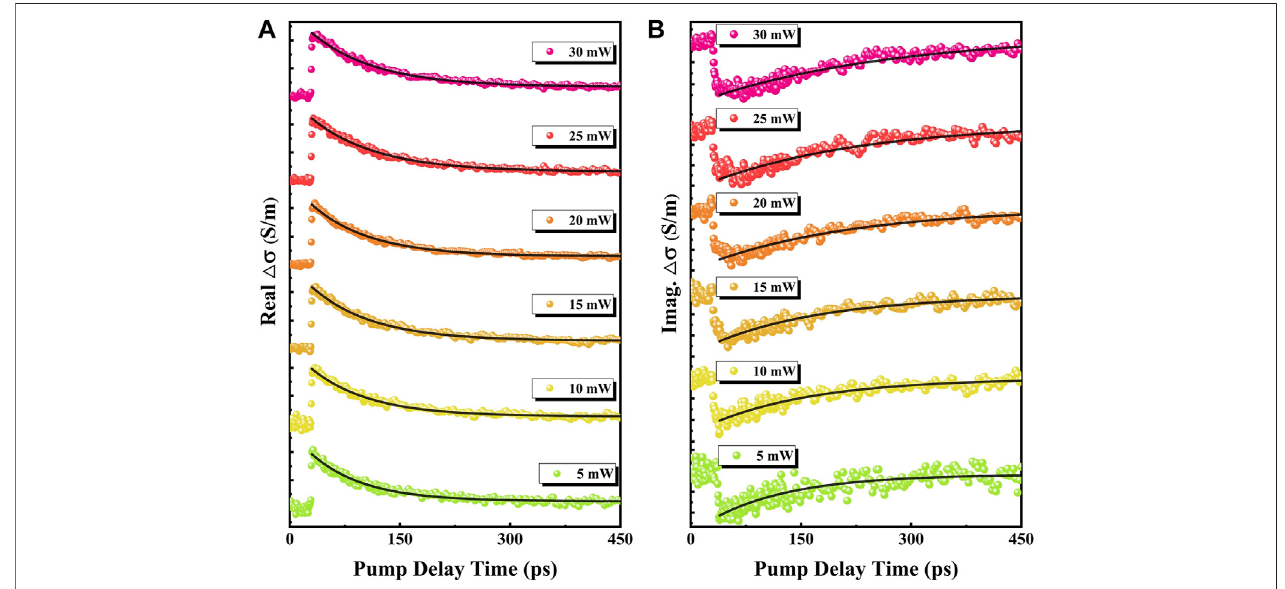
FIGURE 3 | Transient photoinduced real (A) and imaginary (B) parts of the THz conductivity with different pump power. The dots are experimental data, and the solid lines are the exponential fi tting.